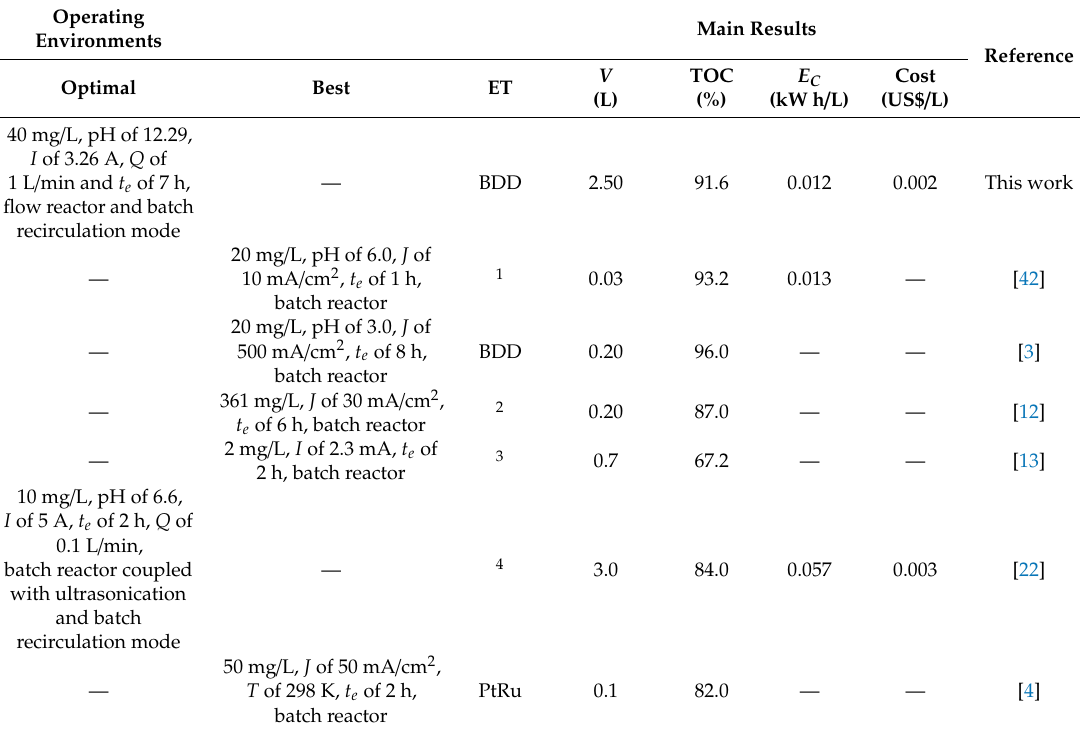
Table 7. Green mineralization of IBU under various operational environments.